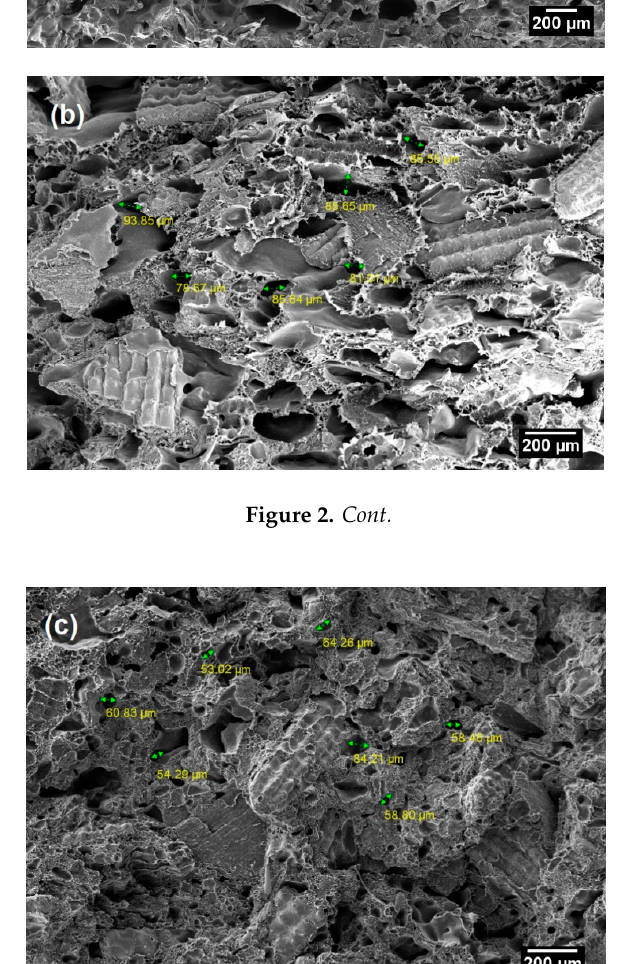
Figure 2. SEM micrographs of RH/rHDPE composite foam with different contents of untreated rice husk (RH) filler: ( a ) 10, ( b ) 30 and ( c ) 50 wt.% .